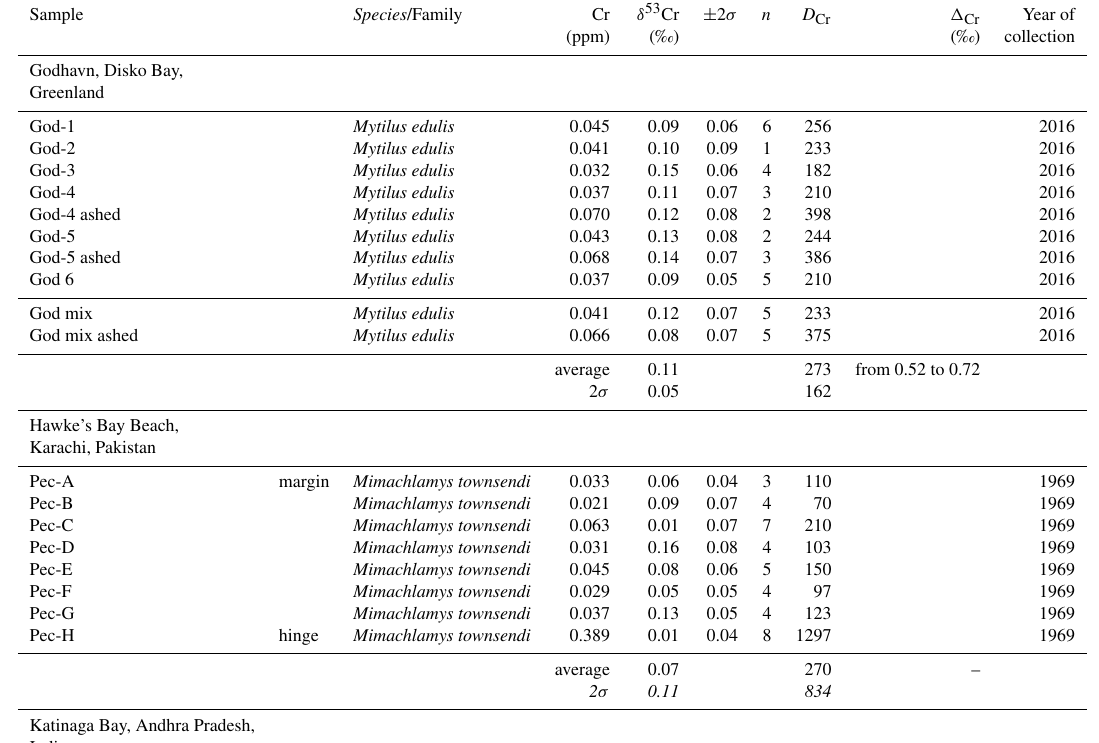
Table 2. Chromium isotope compositions and chromium concentrations of bivalves.